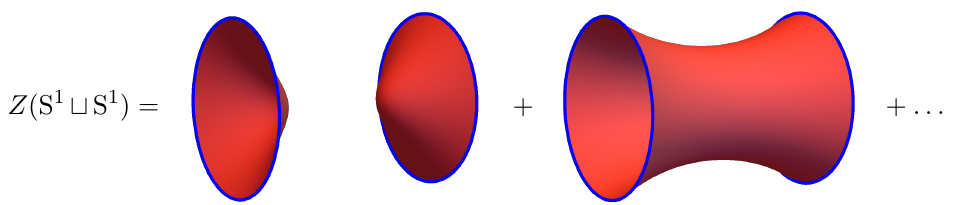
Figure 1 . The gravitational computation of the partition function with two boundary circles in a two-dimensional theory of gravity. The presence of the wormhole geometry generically destroys factorization of the answer and leads to an ensemble dual on the blue